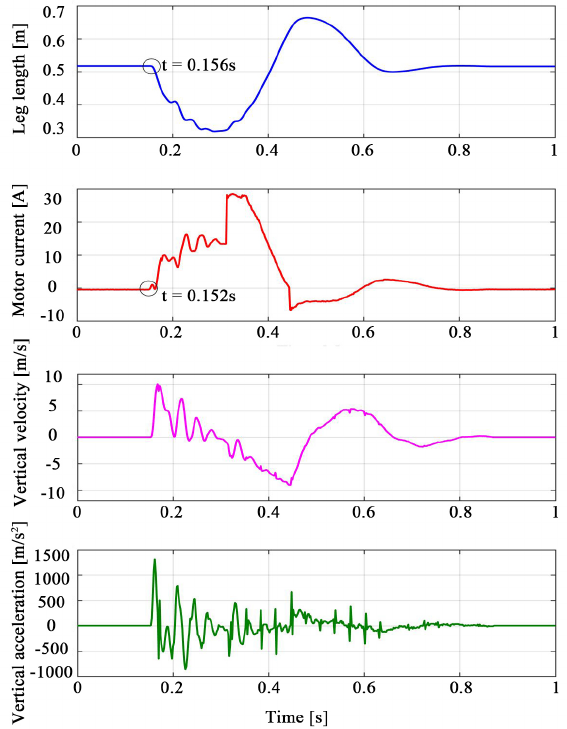
Figure 8. Data recorded during single landing–jumping motion. From top to bottom: leg length; motor current of Joint 1; toe velocity in vertical direction; and toe acceleration in vertical direction. In the graph, black circles represent the moment of change in leg length and motor current. Obviously, the motor current can be used to detect the touchdown information earlier than the leg length.